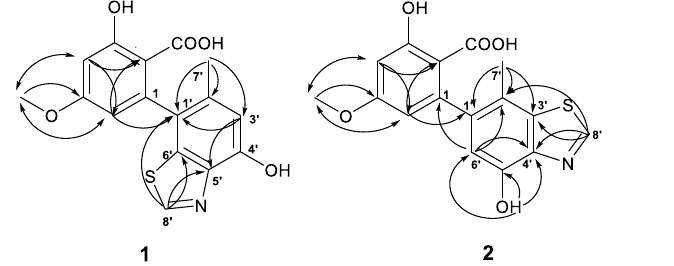
Molecules 2018 , 23 , x FOR PEER REVIEW